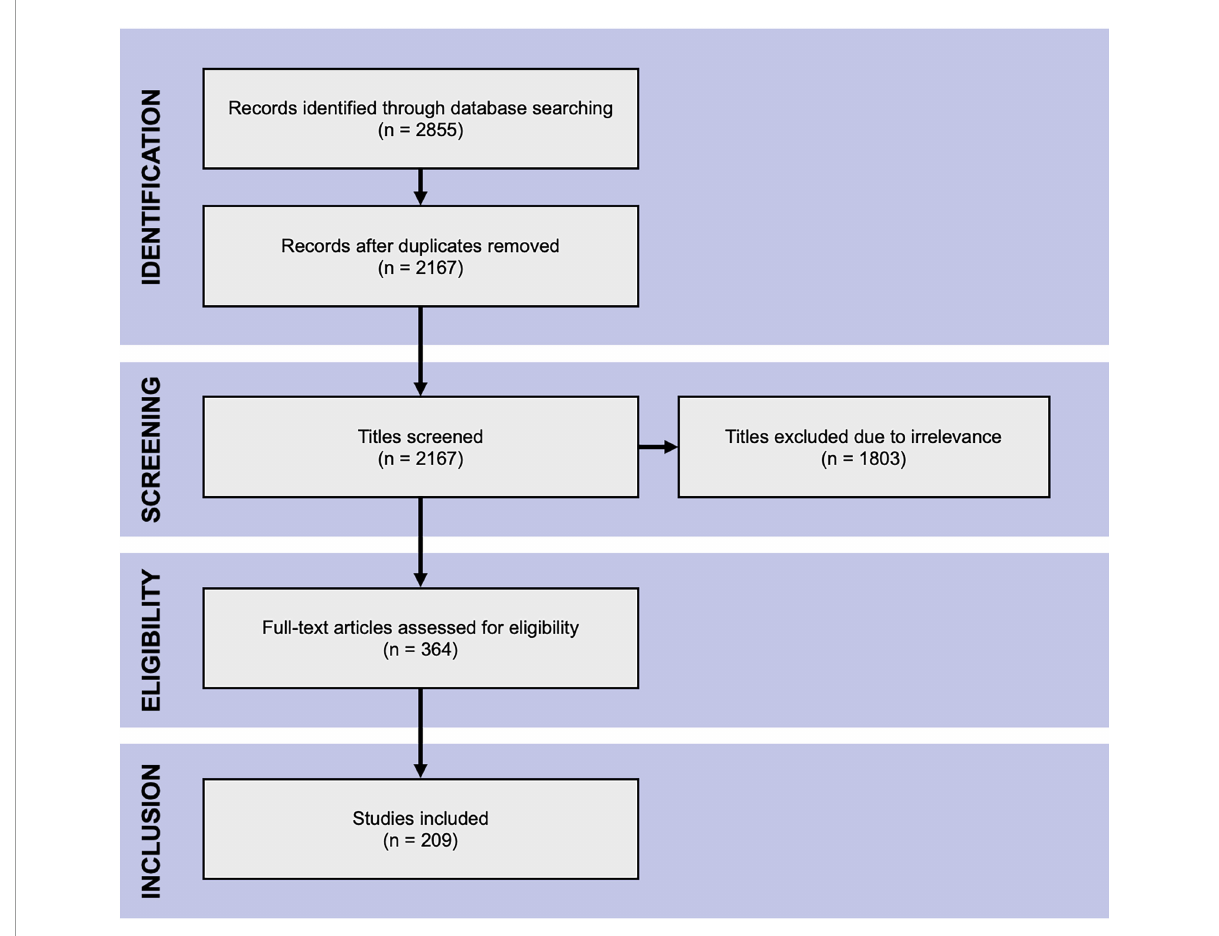
FIGURE2 PRISMA flow chart. The Preferred Reporting Items for Systematic Reviews and Meta-Analyses flow chart of literature